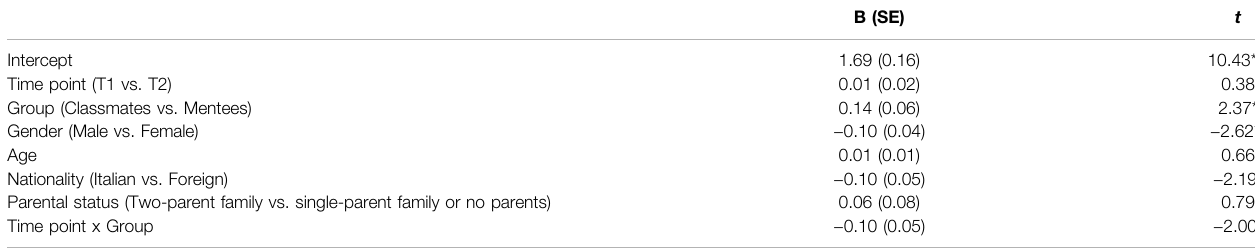
TABLE 2 | Results of linear mixed-effects model: Fixed effects for time point, group (classmates vs. mentees), age, gender (male vs. female), nationality, and parental status (two-parents family vs. single-parent family or no parents) on hyperactivity/inattention.